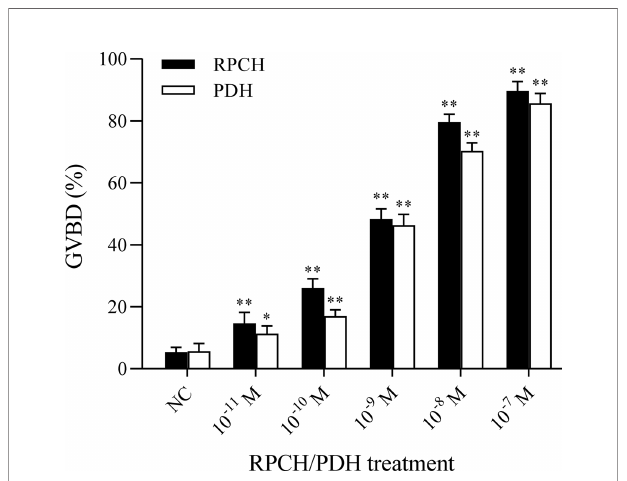
FIGURE 6 | Effects of in vitro culture of the oocytes with the Es-RPCH and Es- b - PDH peptides on the germinal vesicle breakdown index in E. sinensis . A replicate from the control group (NC) was used as a calibrator. Bars represent mean + SD ( n = 5 ). Asterisks (*) and double asterisks (**) represent values statistically different from the control group ( P < 0.05 and P < 0.01).